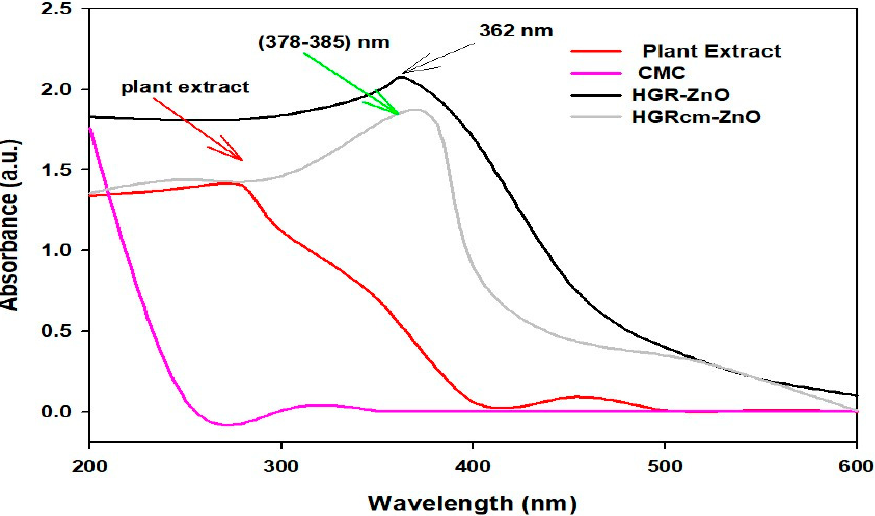
Figure 1. UV-visible spectroscopy confirmation of the formation of hydroponic ginseng root CMC- coated ZnO NPs (HGRCm-ZnO NPs). coated ZnO NPs (HGRCm-ZnO